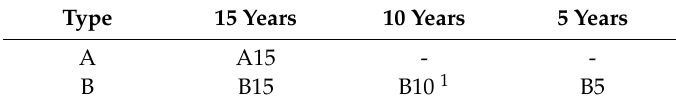
Table 1. Greenhouse classification according to expected design working life [1].